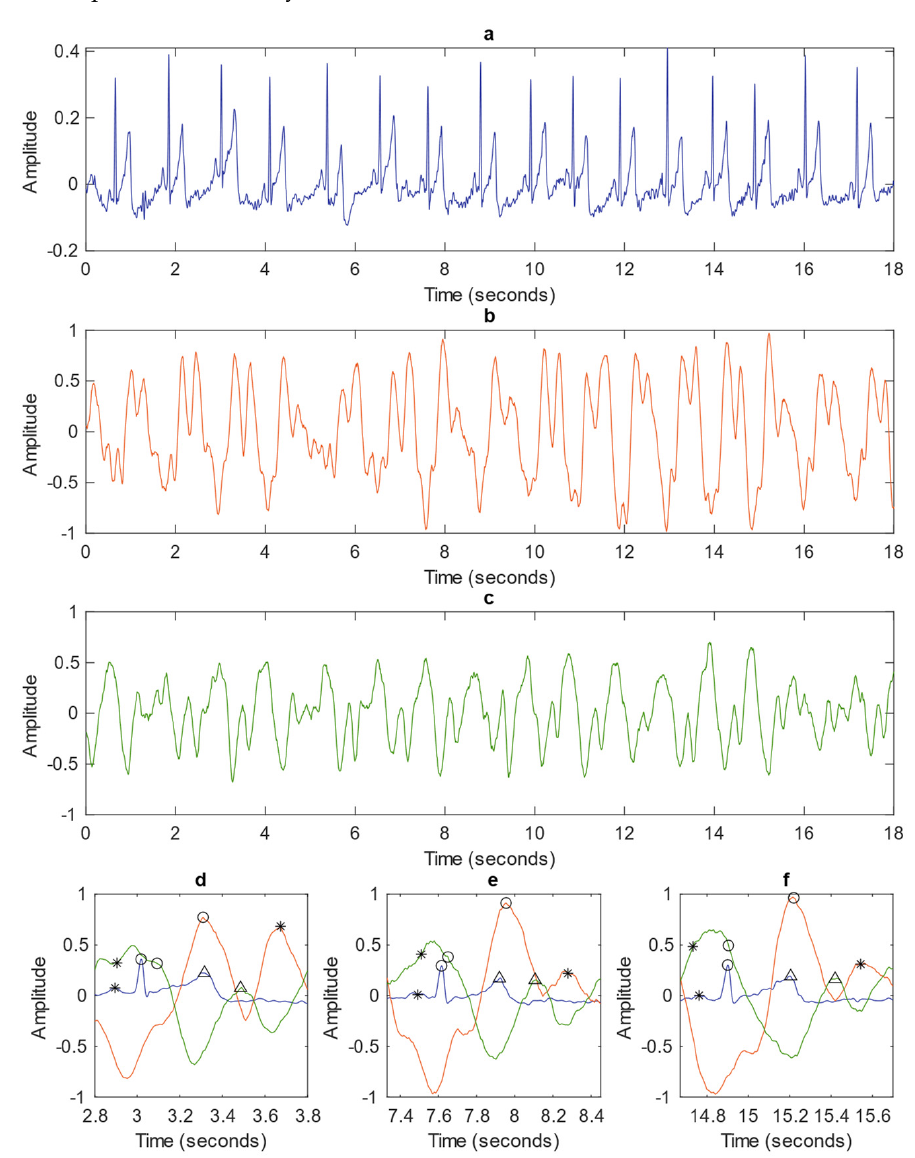
Figure 7. Complete duration of ECG ( a ), SRVI carotid signal ( b ), and SRVI jugular signal ( c ) captured over 18 s. Single cardiac cycles showing the synchronization of all three signal from early in the acquisition period ( d ), the middle of the period ( e ), and the end of the period ( f ). In the single cycle plots ( d – f ), the ECG is depicted in blue (p-wave as a star, r-peak as a circle, t-wave as a triangle), the carotid SRVI signal in red (systolic as a circle, diastolic as a star), and the jugular SRVI signal in green (a-peak as a star, c-peak as a circle, and v-peak as a triangle). Amplitude is in mV for ECG and pixel intensity for SRVI signals.